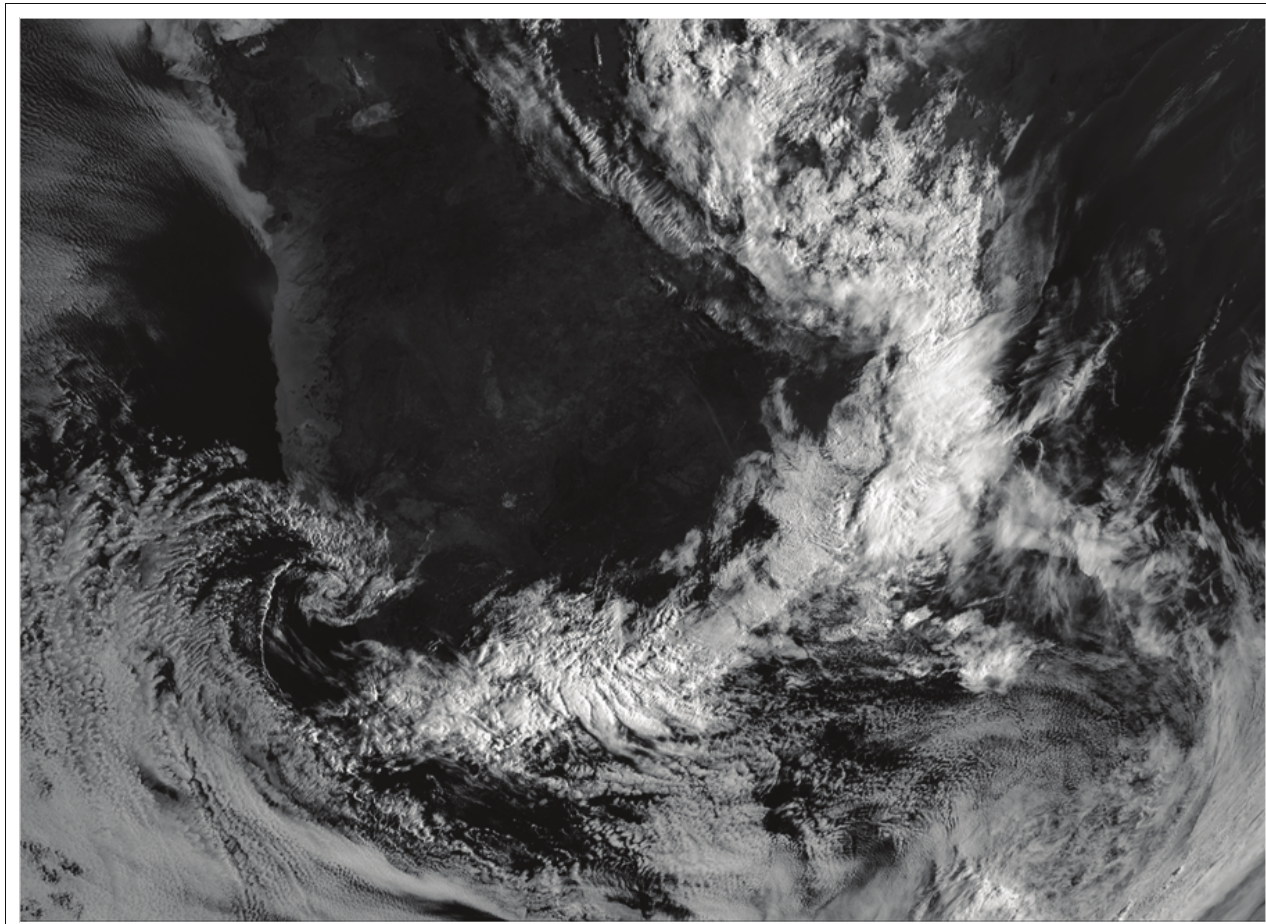
FIGURE 4: A high-resolution satellite image on 20 October